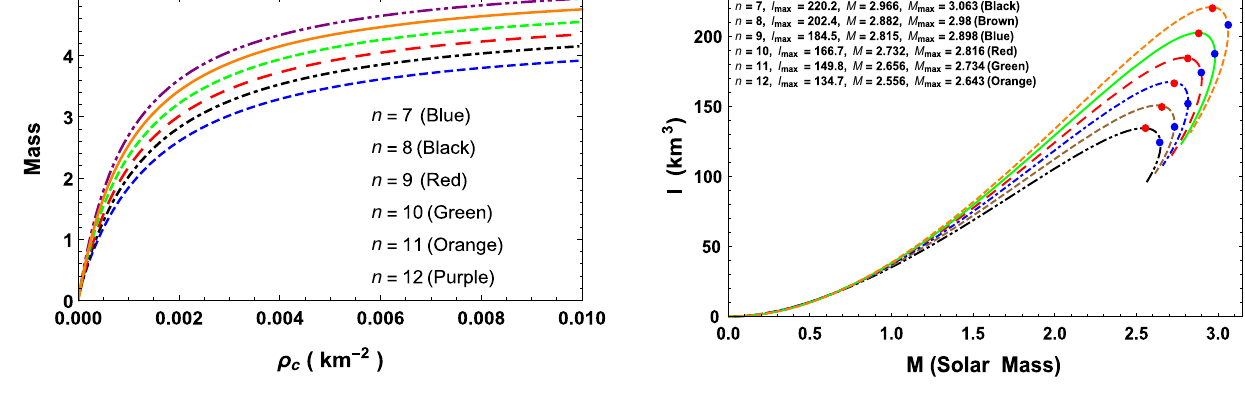
b = 0 . 04. The red dots represents